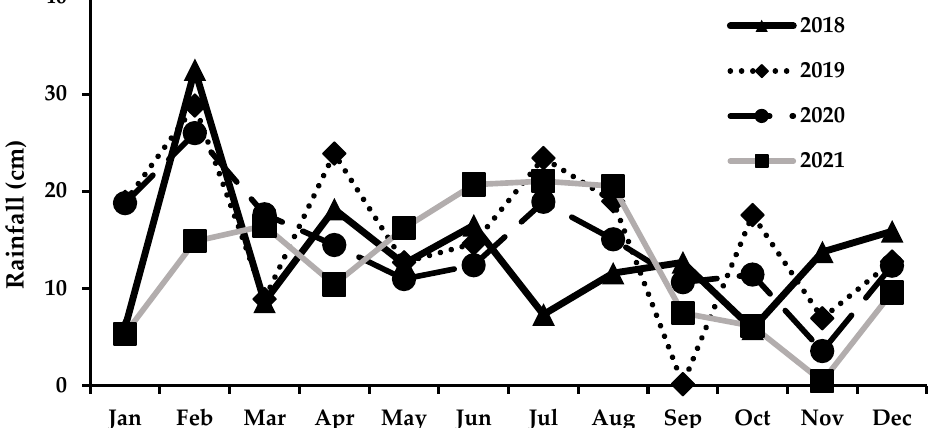
Figure 1. Monthly annual rainfall (cm) at the Pontotoc Ridge-Flatwoods Branch Experiment Station during 2018–2021 growing